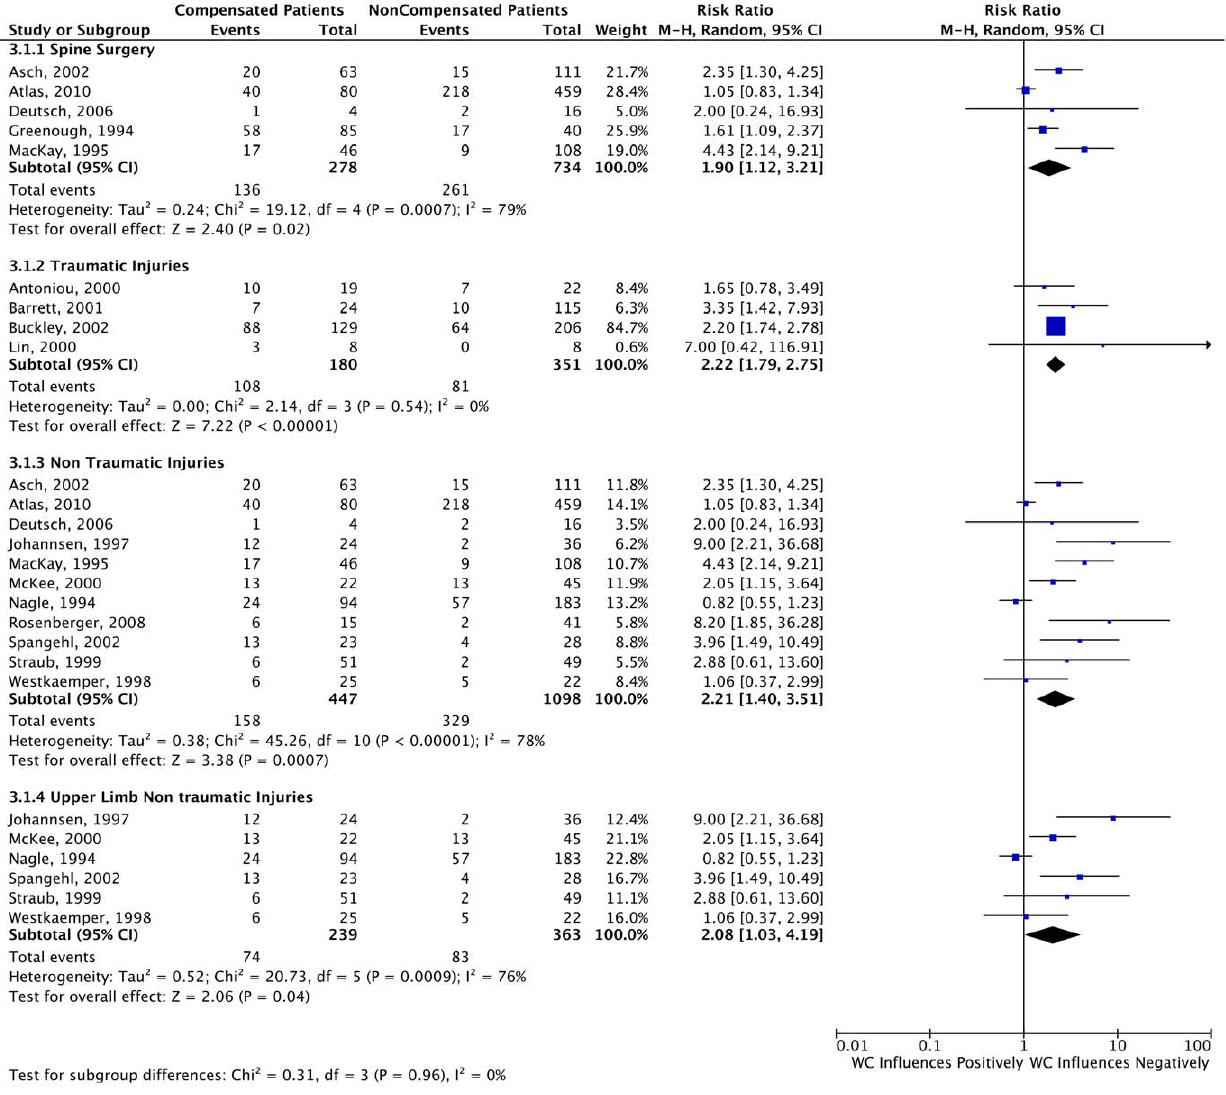
Figure 5. Forest Plots for Studies Reporting Dichotomous Data. This forest plot depicts the results of the subgroups that we decided to analyze a priori.